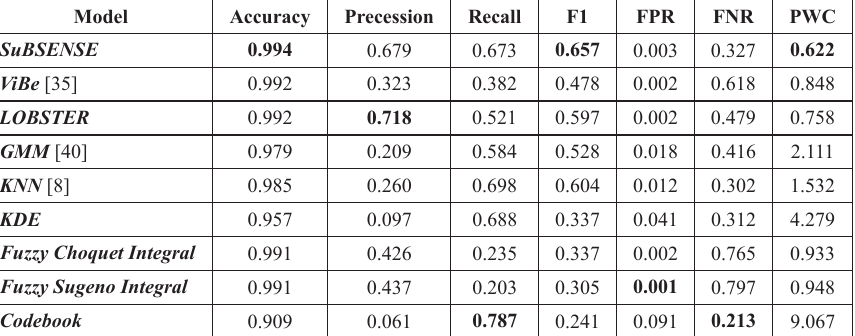
Table 11. Average performance metrics results of applying background subtraction models